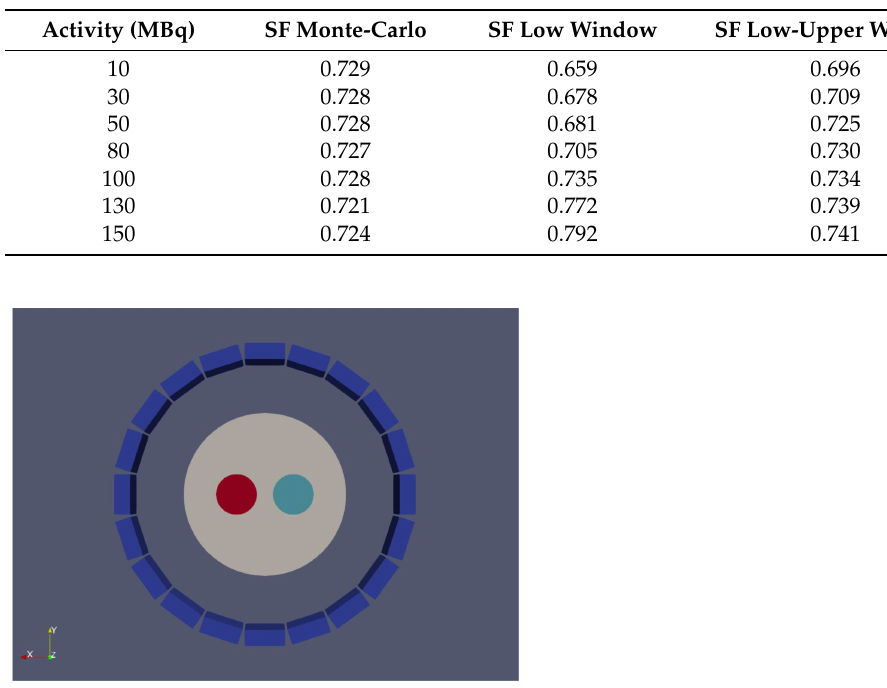
Figure 4. Simulation of a cylindrical source inside a water cylinder 25 mm radius × 160 mm height. The height of the phantom and the source are larger than the height of the FOV of the simulated scanner (50 mm). Table 4. Scatter fraction obtained by Monte Carlo simulations and by the proposed method. A water cylinder and a line source larger than the FoV were simulated.